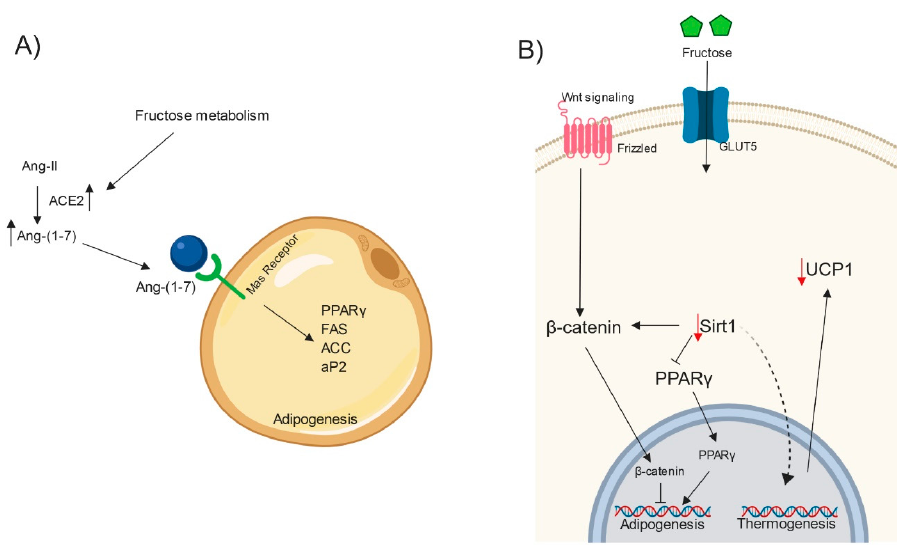
Figure 4. Fructose-induced adipogenesis through Ang-(1–7) and inhibition of thermogenesis. ( A ) Fructose metabolism promotes the conversion from Ang-II to Ang-(1–7) by increasing ACE2 activity. Mas receptor signaling induces the expression of adipogenic genes. ( B ) Sirt1 regulates the thermogenic program by inhibiting PPAR γ and activating Wnt/ β -catenin signalling. High fructose intake inhibits the thermogenic program by downregulating Sirt1 and UCP1 in WAT.